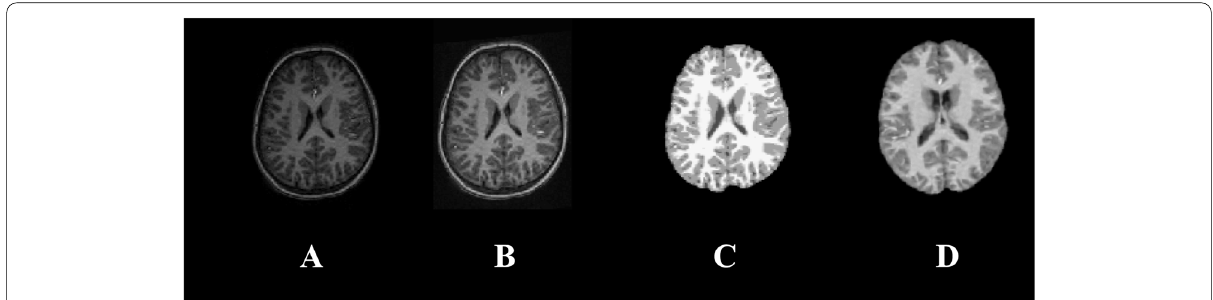
Fig. 2 Stages of preprocessing of structural images of the brain. A Initial image. B Image after intensity normalization. C Segmented image with skull removal. D Image after spatial normalization in DARTEL‑modified space based on MNI. (The image of the main stages of preprocessing)